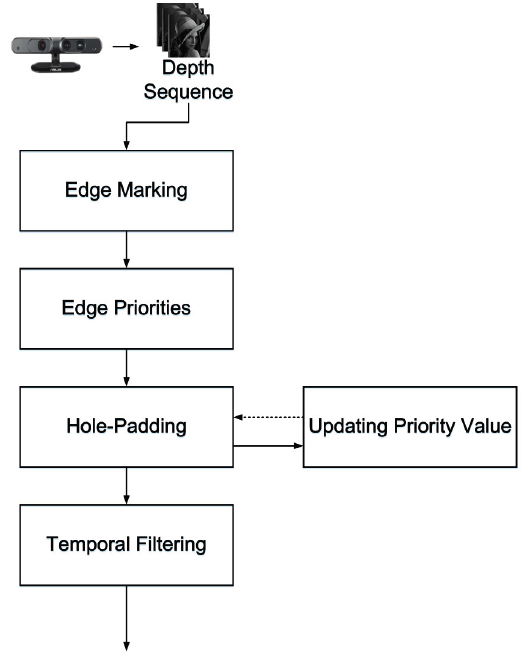
Figure 1. System architecture of the proposed method.